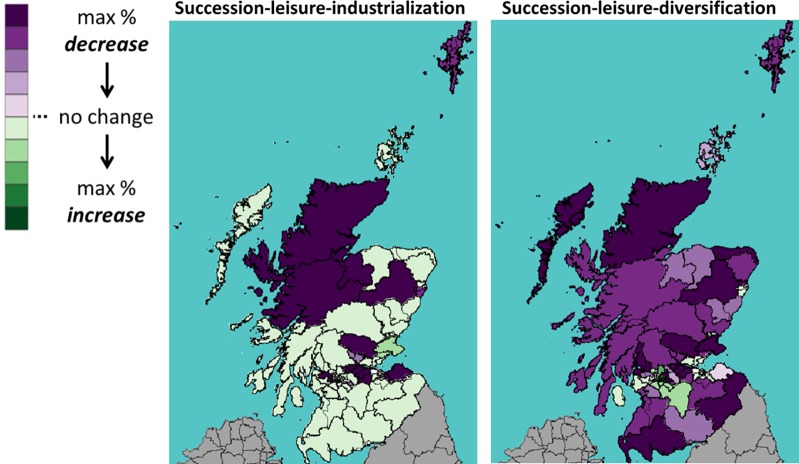
Percentage change in the number of beef cattle under WTO scenario.